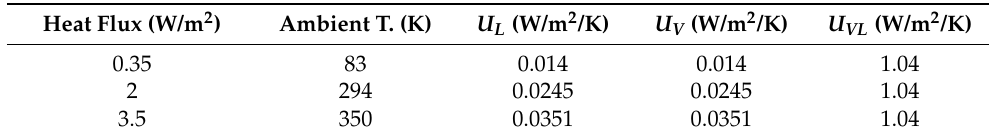
Table 2. Summary of the BoilFAST model inputs used to simulate the LH 2 self-pressurization experiments conducted at NASA’s Glenn Research Centre.